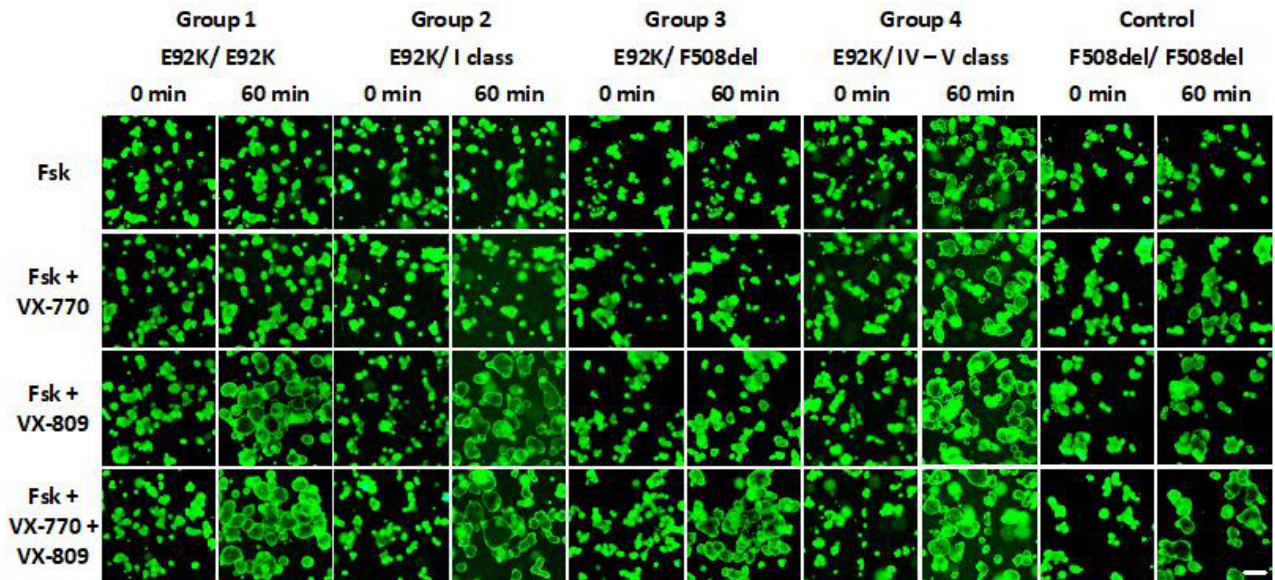
Figure 4. Investigation of the residual functional activity of the CFTR channel and the effect of the VX-770 potentiator and the VX-809 corrector on the rescue of function for homo-/heterozygotes according to the E92K-CFTR variant. Concentrations are 5 µM Fsk, 3.5 µM VX-770 and 3.5 VX-809. The scale bar is 200 microns.